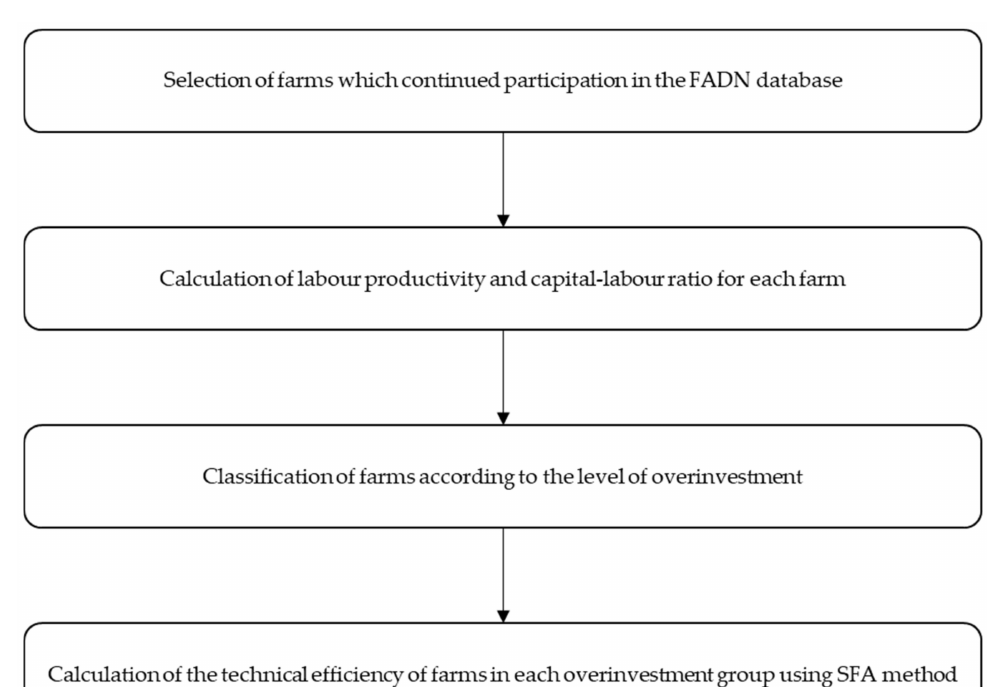
Figure 2. Research procedure scheme. Source: own